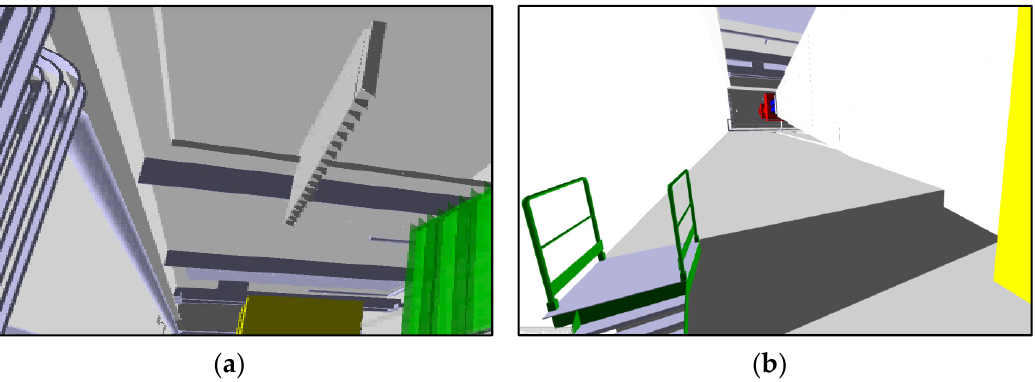
Figure 22. Interference between models in Navisworks: ( a ) size of the access opening; ( b ) the height of the underground hall.